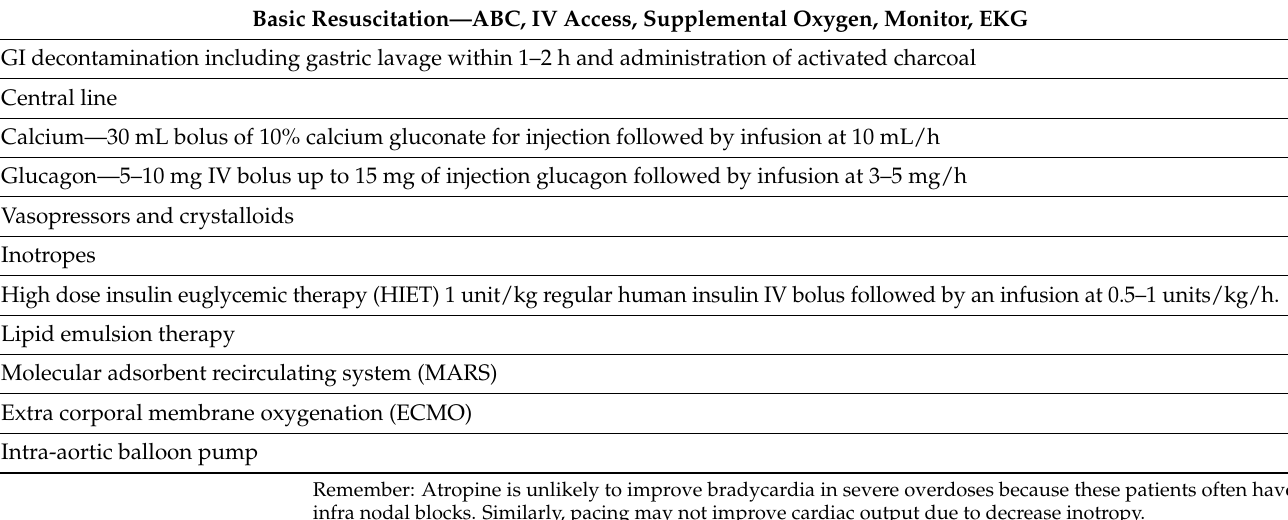
Table 2. Treatment Options for Amlodipine